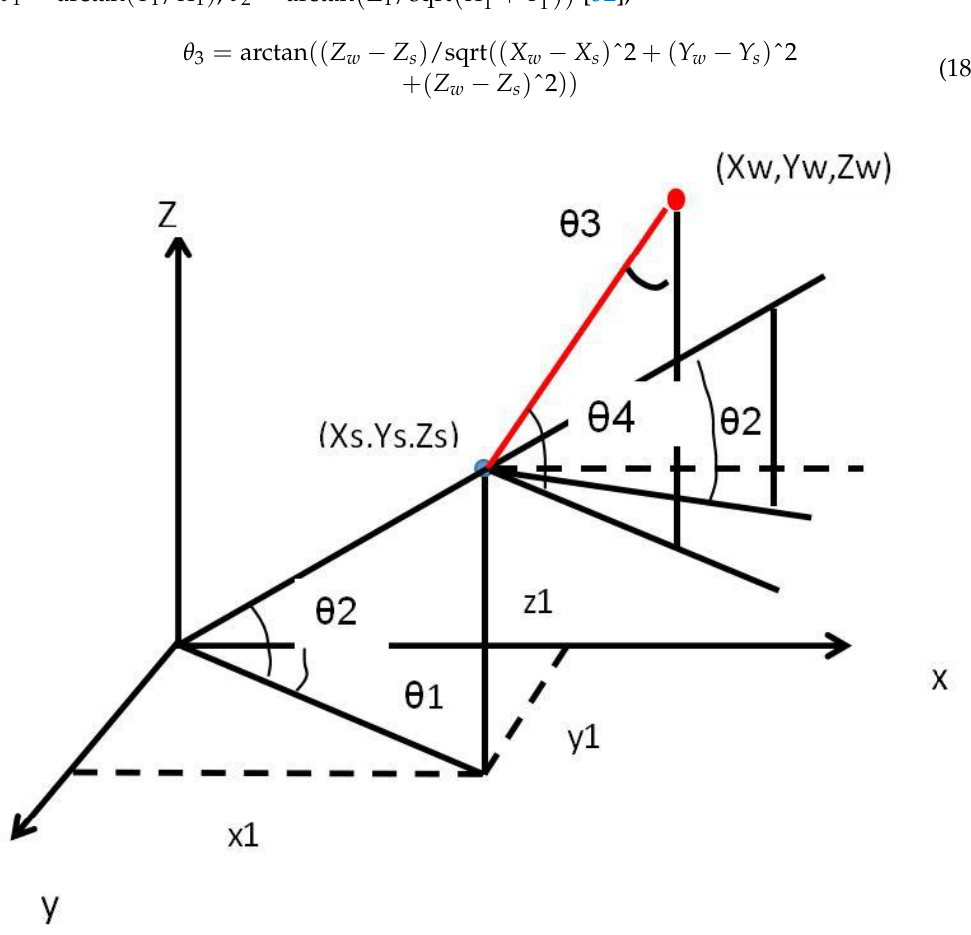
Figure 2. Ray angle diagram (red line is the signal line). θ 4 = 90 ◦ − θ 3 , By using the sine of θ 4 to project the distance between the grids in the X-axis direction into the distance between the intersections on the signal line, the intersection coordinate of the X-axis profile and the signal line can be obtained by using the range limit of the X value. According to the same method, the intersection coordinates of the signal line and the Y (Z) axis profile can be calculated, as shown in Figure 3. Therefore, by sorting all the intersection coordinates obtained above according to the Z coordinate, the spatial position order of all intersections can be obtained. Because the coordinates of